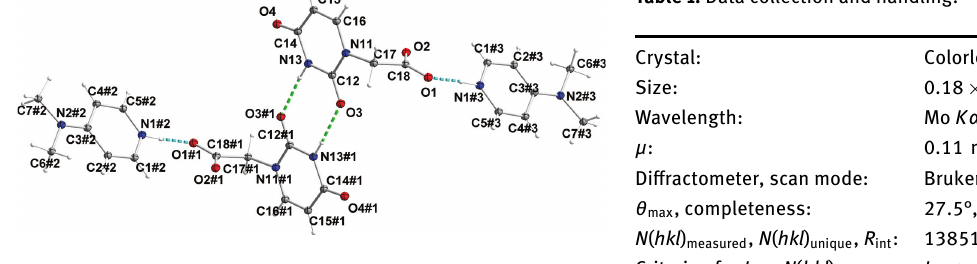
Table 1: Data collection and